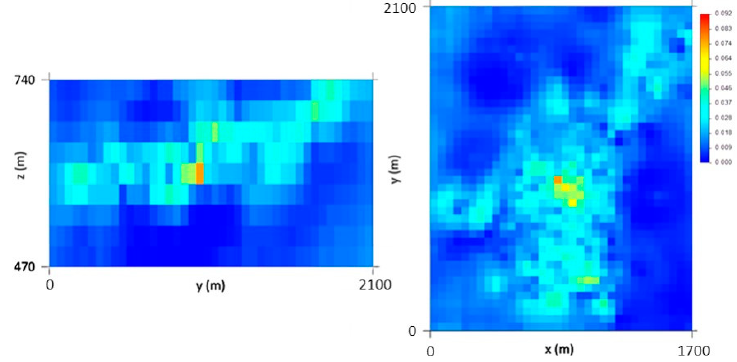
Figure 3. The results of stope vein proportion estimation (OK): Px81 (left) and Pz75 (right).